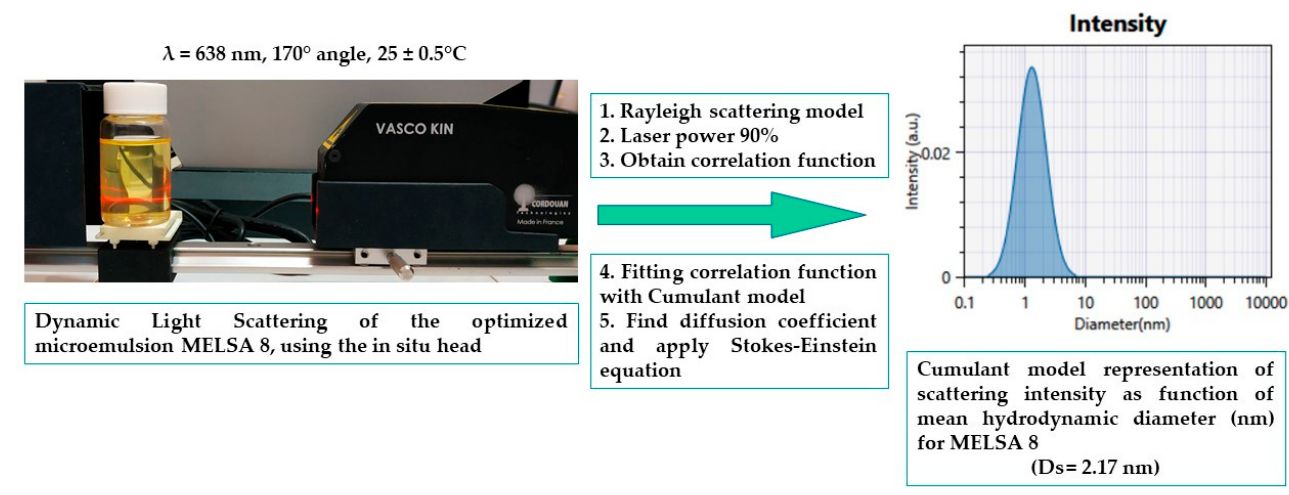
Figure 7. Representation of dynamic light scattering for the optimized microemulsion MELSA 8, using the in-situ head of ViscoKin particle analyzer, and five steps that are followed to assess the response related with the Cumulant